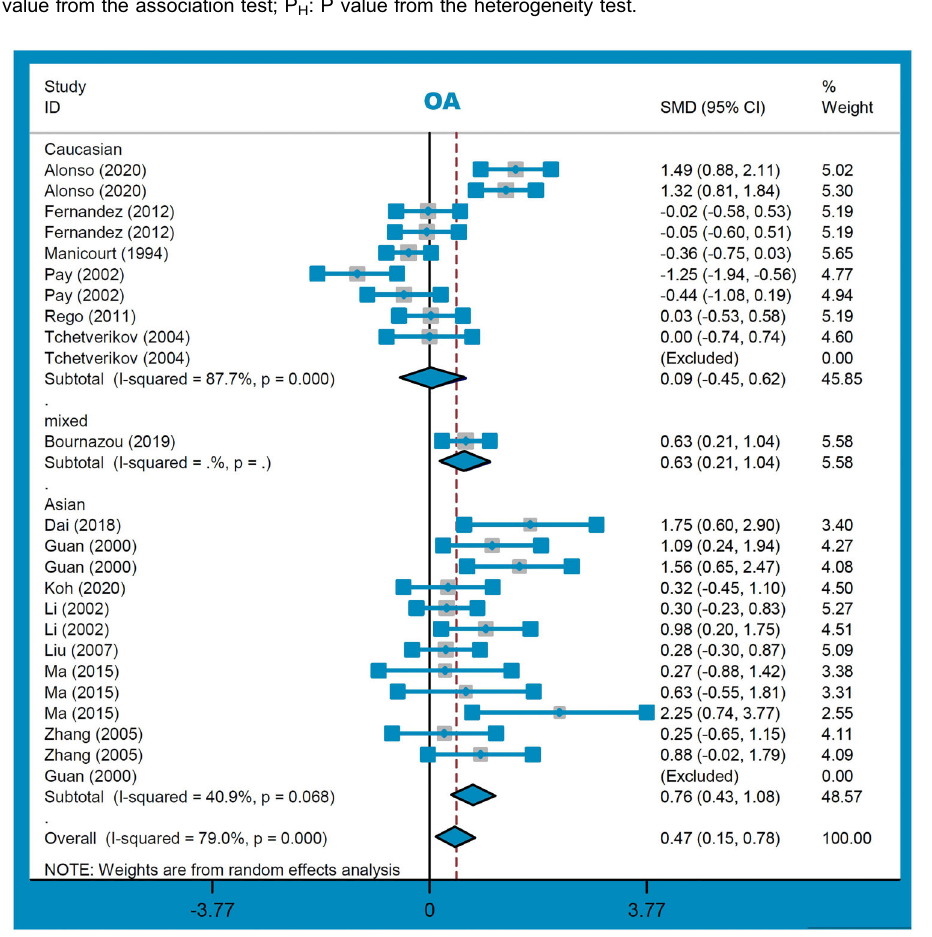
Figure 3. Subgroup analysis by ethnicity for osteoarthritis (OA) risk. See Supplementary Table S1 for reference numbers.